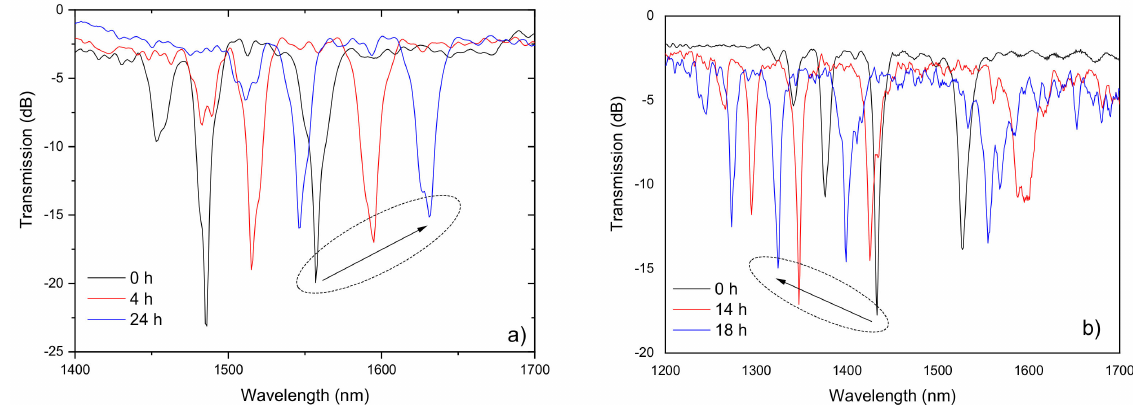
Figure 9. Evolution of the spectra of two gratings written in the ( a ) SMF28 fiber; and in a ( b ) nitrogen doped fiber during annealing at 1000 ◦ C. Adapted with permission from ref. [97]. © 2021